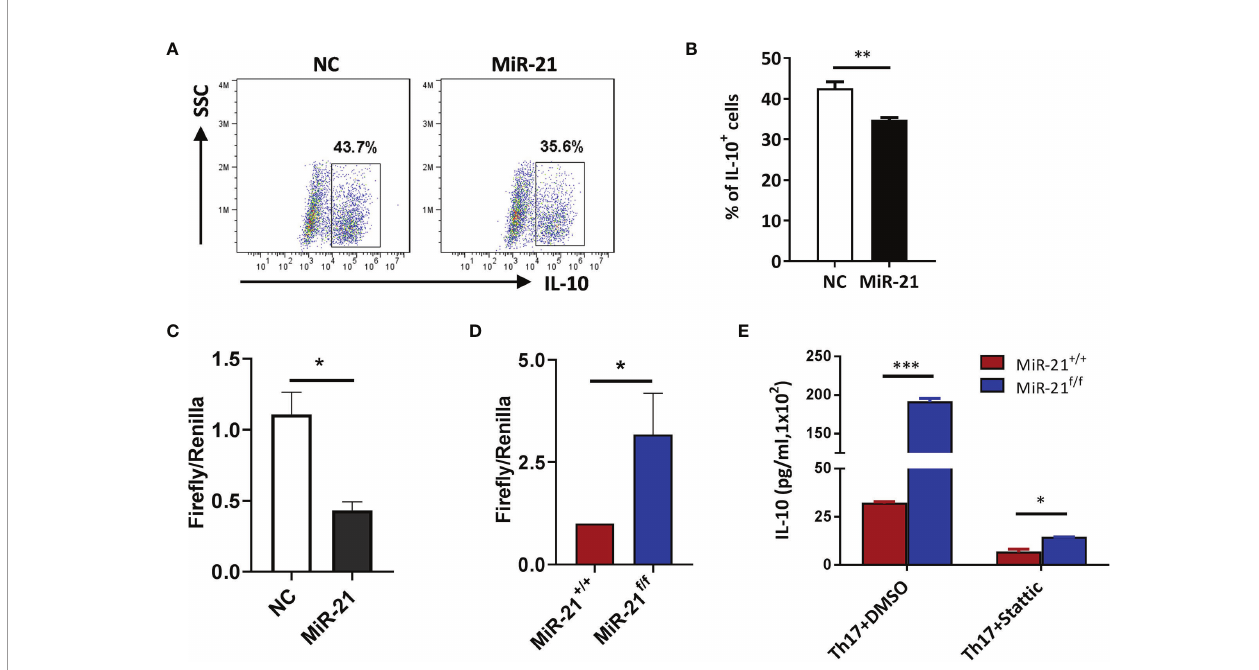
FIGURE 5 | IL-10 is a direct target of miR-21 in Treg cells. (A, B) CD4 + CD25 + Treg cells were isolated from the spleen of C57BL/6 mice using EasySep Mouse CD4 + CD25 + Treg Cell Isolation Kit and cultured with a -CD3 plus a -CD28 and IL-2 for 48 h before control adenovirus (NC) or adenovirus over-expressing miR-21 (miR-21) were added. After culture for another 48 h, cells were treated with Th17 priming cytokines for 72 h. Cells were then fi xed, permeabilized, stained with anti – IL-10 and examined by fl ow cytometry (A) . The quanti fi cation of the proportion of IL-10 + cells was shown in (B) . Cells shown in (A) were gated on transduced cells. (C, D) CD4 + CD8 - YFP + cells were fl ow sorted from the spleen of Foxp3 Cre-YFP miR-21 +/+ (MiR-21 +/+ ) and Foxp3 Cre-YFP miR-21 f/f (MiR-21 f/f ) mice (n=5). MiR-21 agomir was electroporated into CD4 + CD8 - YFP + cells from Foxp3 Cre-YFP miR-21 +/+ mice together with mouse IL-10 3 ’ UTR reporter construct (C) . Alternatively, mouse IL-10 3 ’ UTR reporter construct was electroporated into CD4 + CD8 - YFP + cells from Foxp3 Cre-YFP miR-21 +/+ and Foxp3 Cre-YFP miR-21 f/f mice (D) . Cells were then cultured for 24 h and luciferase activity was examined using a dual-luciferase reporter assay system. (E) CD4 + CD8 - YFP + cells were fl ow sorted from the spleen of Foxp3 Cre- YFP miR-21 +/+ (MiR-21 +/+ ) and Foxp3 Cre-YFP miR-21 f/f (MiR-21 f/f ) mice (n=5). Cells were pre-treated with either DMSO or Stat3 inhibitor (Stattic) for 1h and then cultured with a -CD3 plus a -CD28 in the presence of Th17 priming cytokines for 72 h. Culture supernatants were collected and the protein level of IL-10 was determined by ELISA. Data are representative of three separate experiments. *p < 0.05, **p < 0.01, ***p <